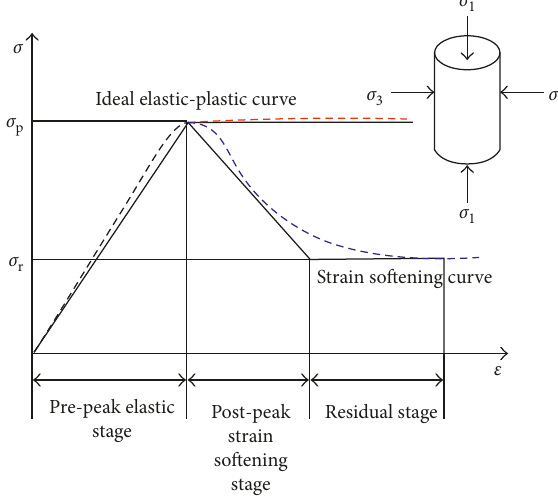
Figure 2: Test curves and idealized stress-strain